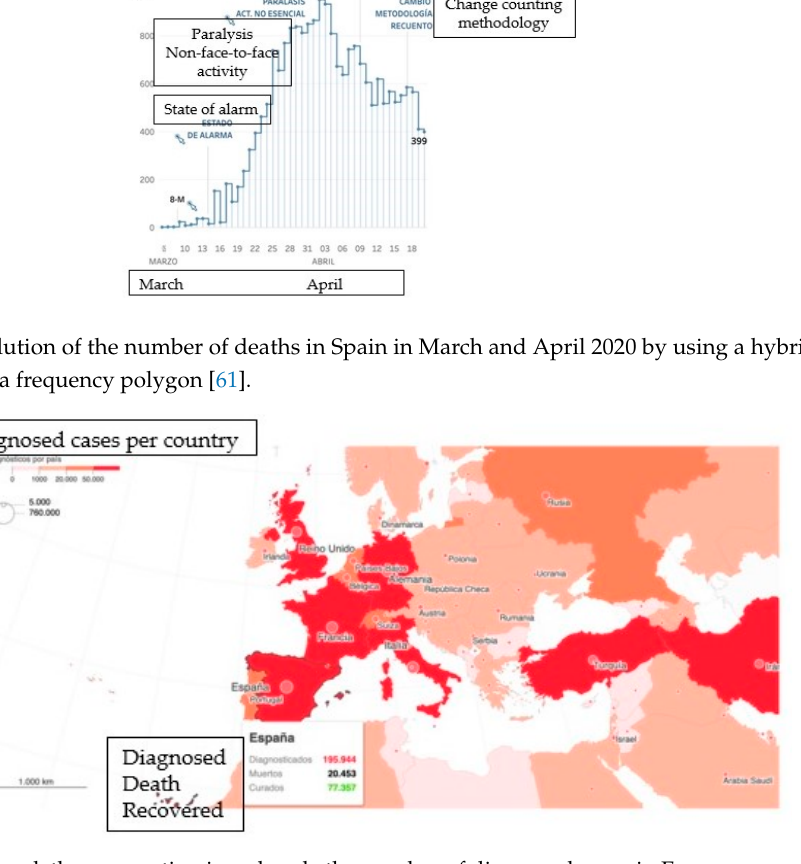
Figure 8. Choropleth representing in red-scale the number of diagnosed cases in Europe, per country, by 20 April 2020 [62]. A period is used to indicate the decimal place.